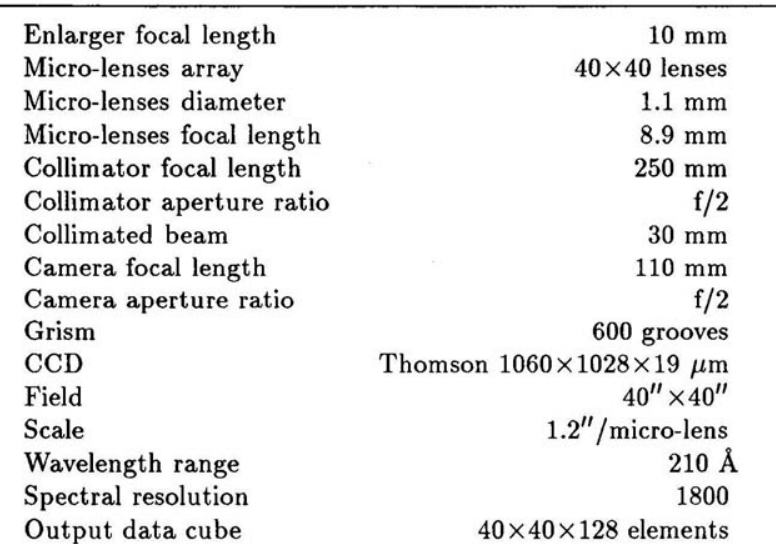
Table 1. Parameters of the spectrograph